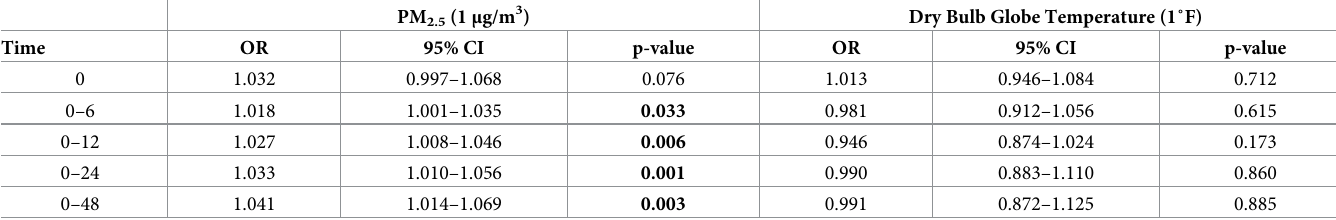
Table 5. Adjusted odds ratios of rescue bronchodilator usage for PM 2.5 and DBGT in the same model for participants in the summer.